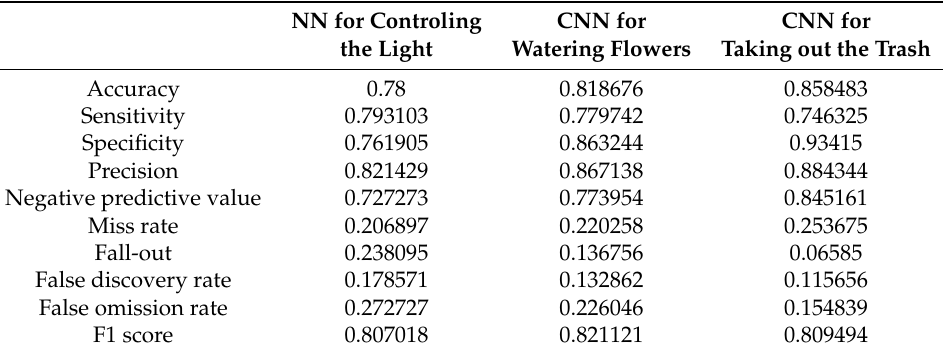
Table 1. Statistical parameters for all tested classifier.